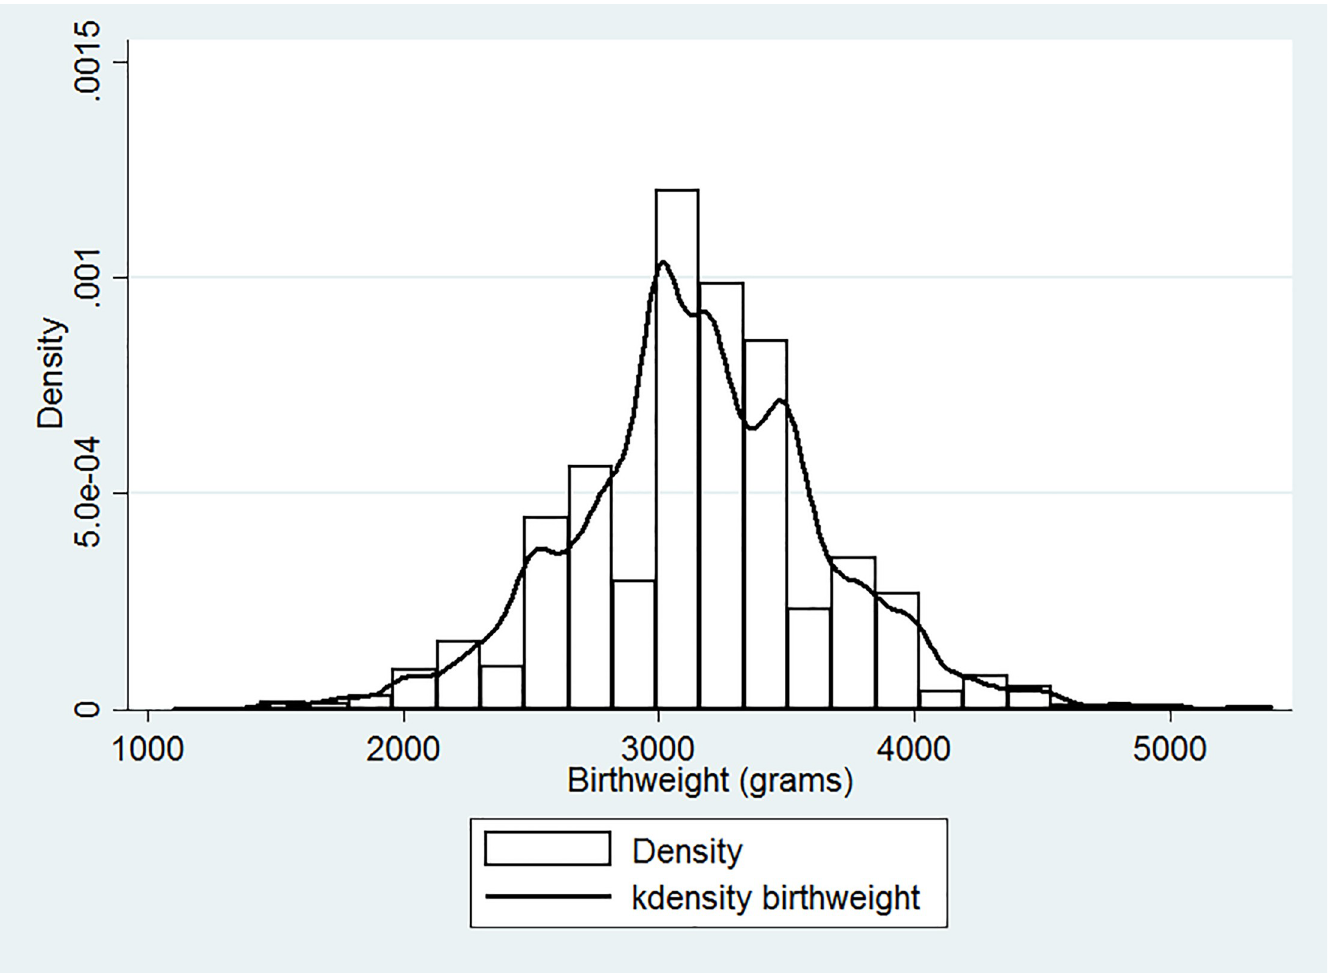
Fig 1. Histogram and Kernel distribution of